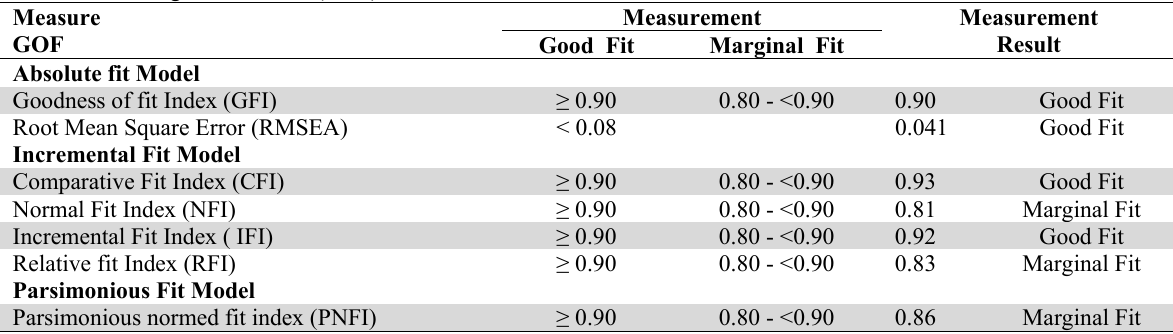
The results of the goodness of fit (GOF) Measure